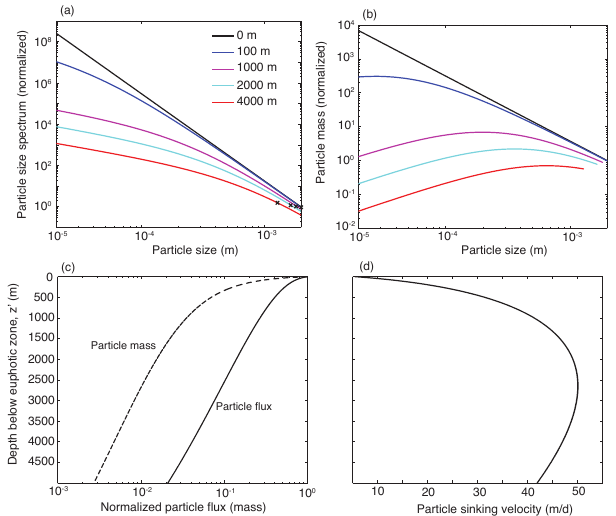
Figure 1. (a) The size distribution, n , of particles as a function of depth and particle size class as predicted by Eq. (8) for the sur- face size range D S = 20µm to D L = 2000µm. Black x ’s mark the upper size limit of particles at each depth from Eq. (11). (b) The mass of particles within each size class with depth. (c) The nor- malized integrated particle mass and particle flux with depth us- ing the size distribution from (a) . (d) The mass-weighted particle sinking velocity with depth. All calculations used the following parameter values: c w = 2 . 2 × 10 5 m 1 − η d − 1 (Kriest and Oschlies, 2008), (cid:15) = 4 . 2 (Kostadinov et al., 2009), η = 1 . 17 (Smayda, 1970), ζ = 2 . 28 (Mullin et al., 1966), c r = 0 . 03d − 1 (Kriest and Oschlies,